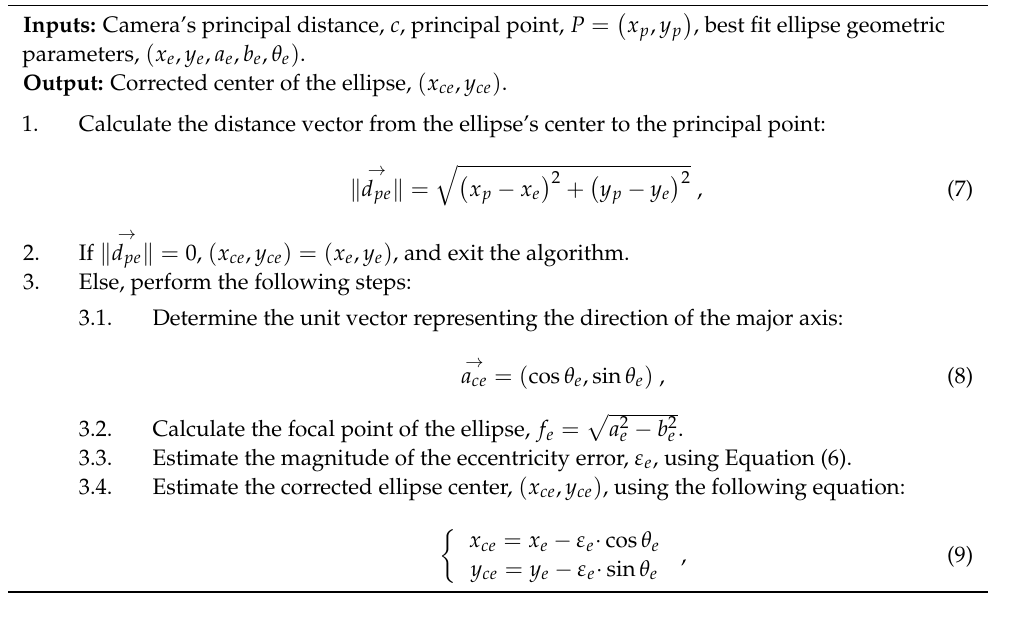
Algorithm 1 Corrected Ellipse